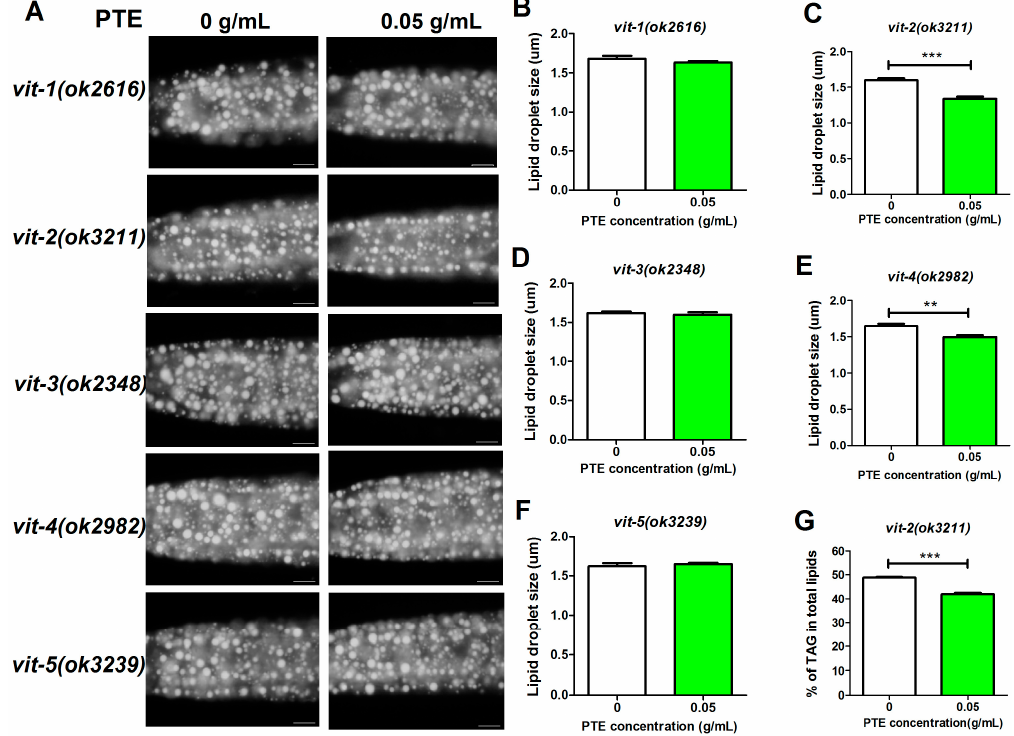
Figure 3. Nile Red staining of fixation and lipid droplets size of vits mutants treated by PTE. ( A ) Nile Red staining of late L4 worms treated with different concentrations of PTE. Presented animals, anterior is on right, and posterior is on left. Exposure time: 25 ms. Scale bar represents 20 μ m; ( B – F ) quantification of lipid droplet size. Data are presented as ± SEM of 10 worms; and ( G ) percentage of TAG in total lipids (TAG + PL, phospholipids). Data are presented as mean ± SEM of four biological independent repeats. Significant differences between PTE treated group (0.05 g/mL) and the control group (0 g/mL), *** p < 0.001, ** p < 0.01.